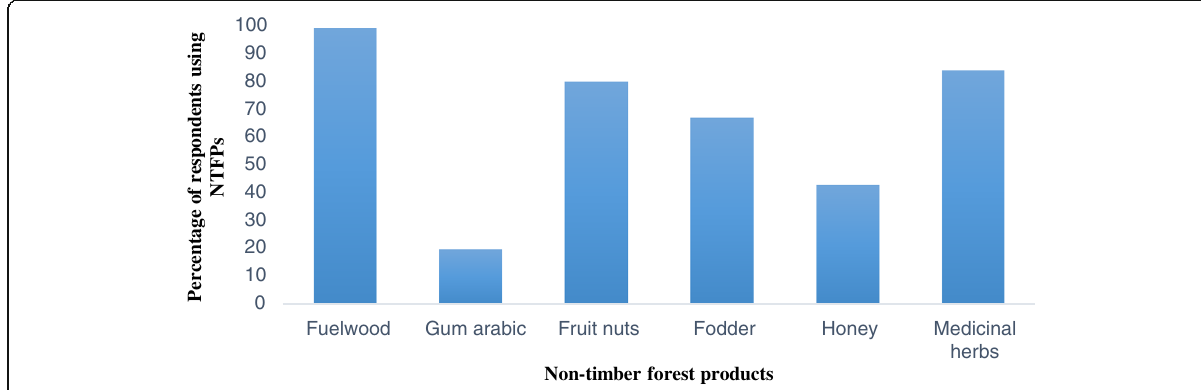
Fig. 2 Main non-timber forest products collected by the households from Falgore Game